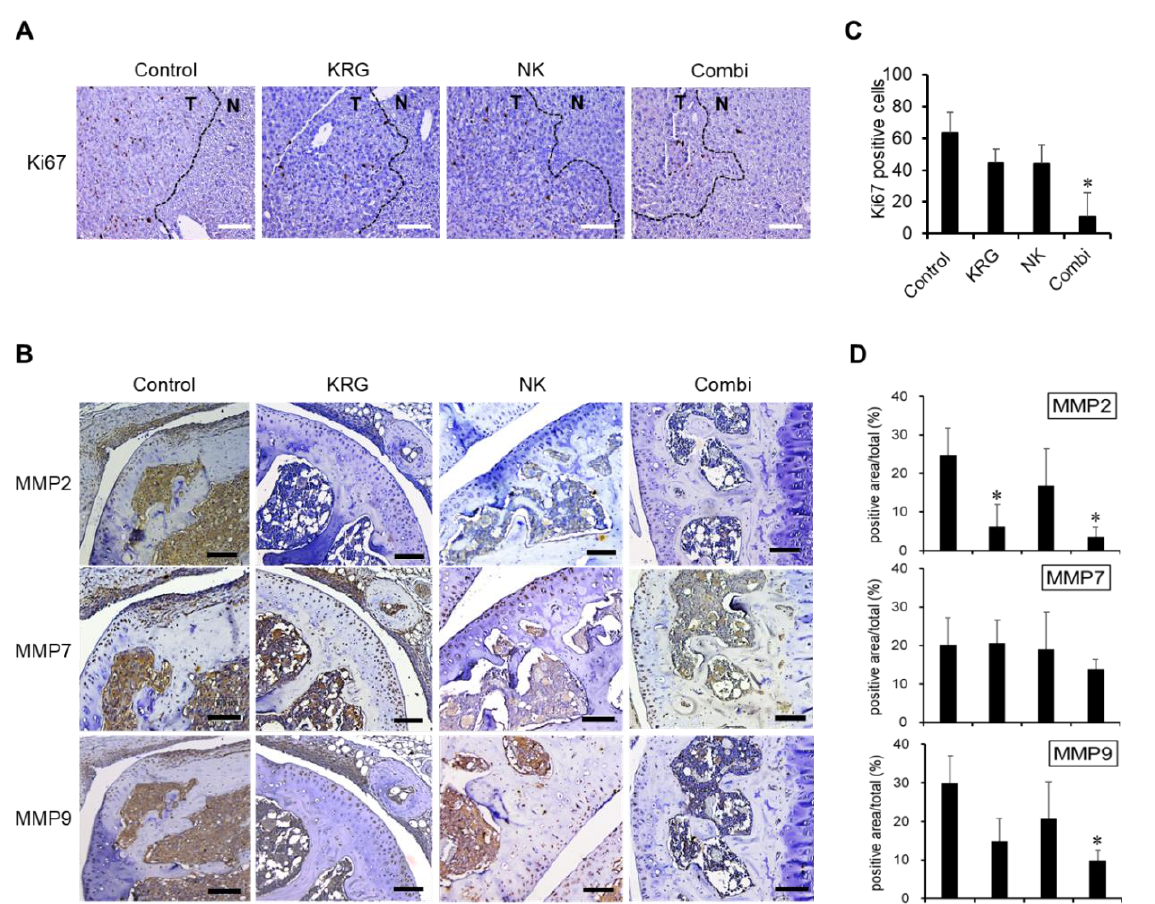
Figure 2. Inhibition of matrix metalloproteinases and Ki67 levels by KRG and NK cells. ( A ). Expres- sion of Ki67 in metastatic lesions of liver tissues. Brown dots represent Ki67-expressing cells. T, tumor site; N, normal site. Scale bar, 100 μm. ( B ). Quantification of Ki67-expressing cells in the tumor site. Data are expressed as the mean ± SD (randomly three points in each slide. n = 2/group). *, p < 0.05 (one-way ANOVA with a Dunnett’s post hoc test). ( C ). Expression of matrix metalloproteinases (MMPs) in metastatic lesions of the epiphysis. Brown dots represent MMP-expressing cells. Scale bar, 100 μm. ( D ). Quantification of MMPs in the metastatic lesions. Data are expressed as the mean ± SD (randomly three points in each slide. n = 2/group). *, p < 0.05 ( vs control, two-way ANOVA with a Tukey’s post hoc test).